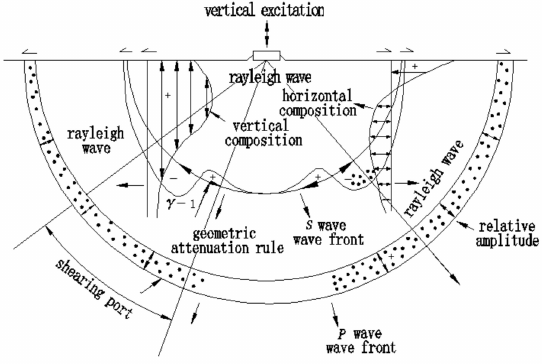
Figure 1. Schematic elastic wave propagation generated by impact excitation